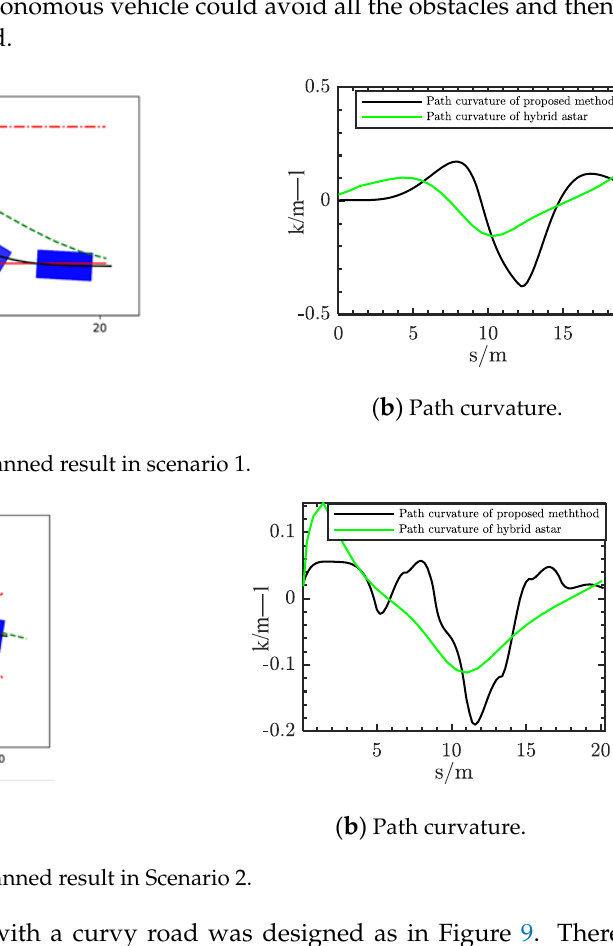
Figure 8. Planned result in Scenario 2.